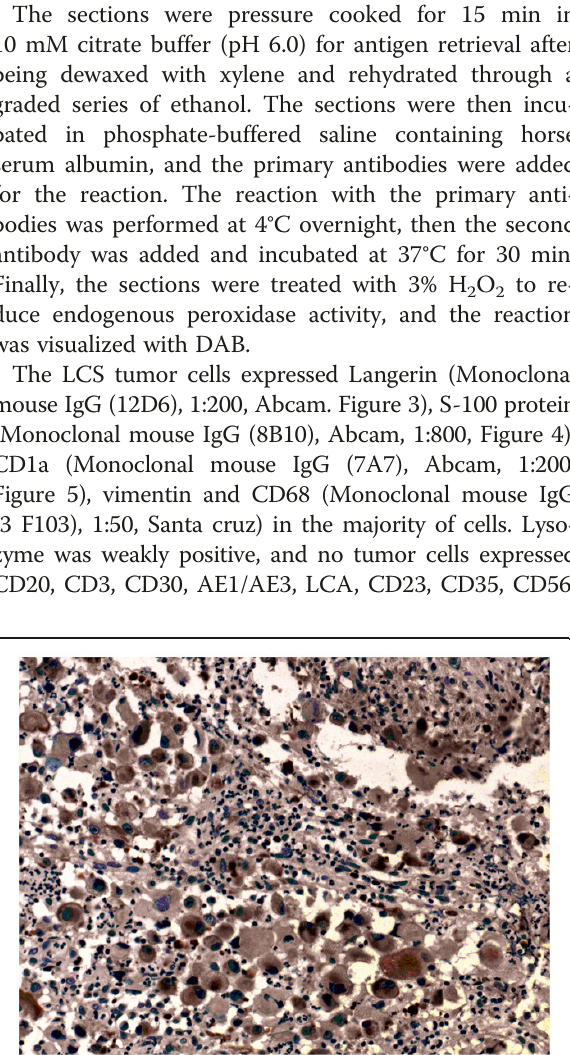
Figure 3 LCS tumor cells expressed Langerin